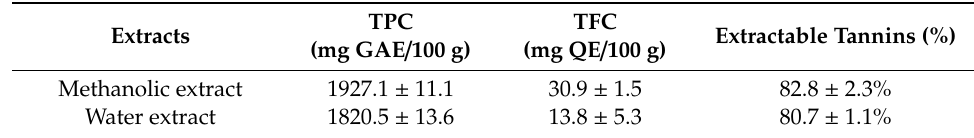
Table 1. Total polyphenols content (TPC) and total flavonoids content (TFC), extractable tannins of two extracts of A. seyal